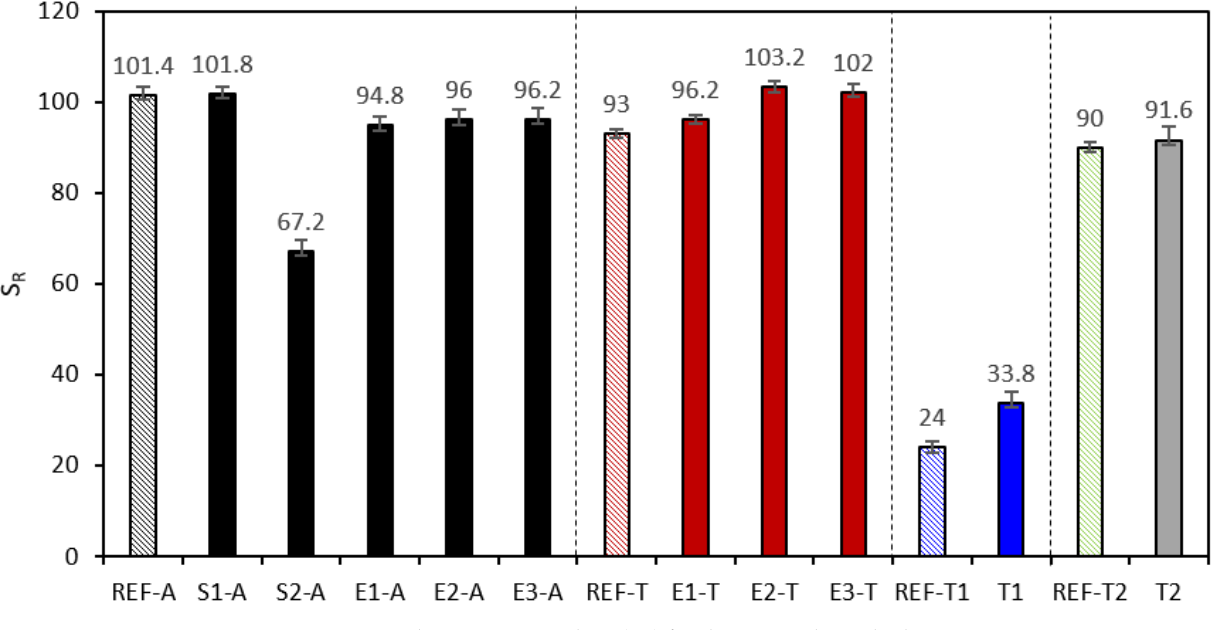
Figure 11. Slip resistance values ( S R ) for the materials studied. The surface profiles for samples Ref-A and S2-A generated from photos with ImageJ software are reproduced in Figure 12. The figure reveals the obvious difference between surfaces for the plain asphalt (Ref-A) and sample S2-A, where slurry S2 filled the voids, generating a smooth surface.